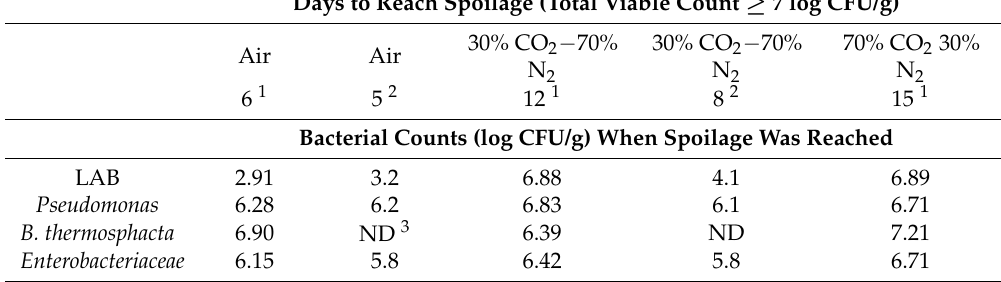
Table 3. Comparison of bacterial counts at spoilage time after storage under air or under two different